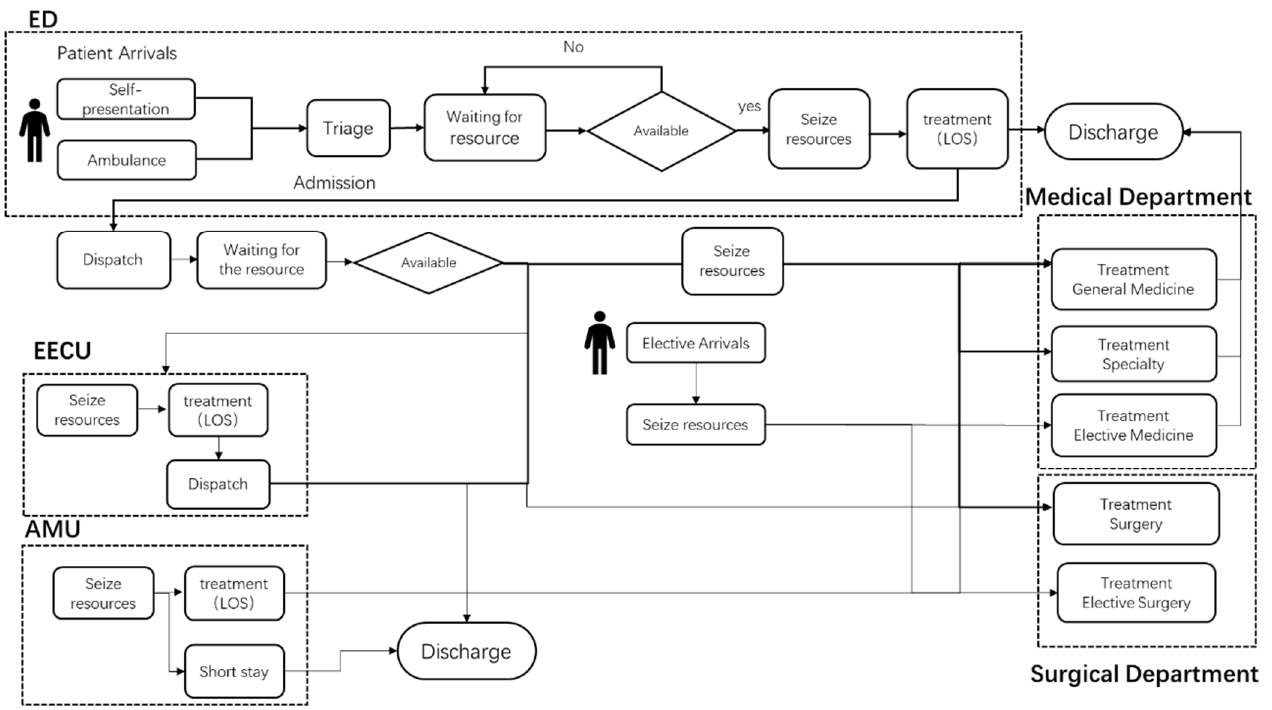
Figure 1. Patient flow of the